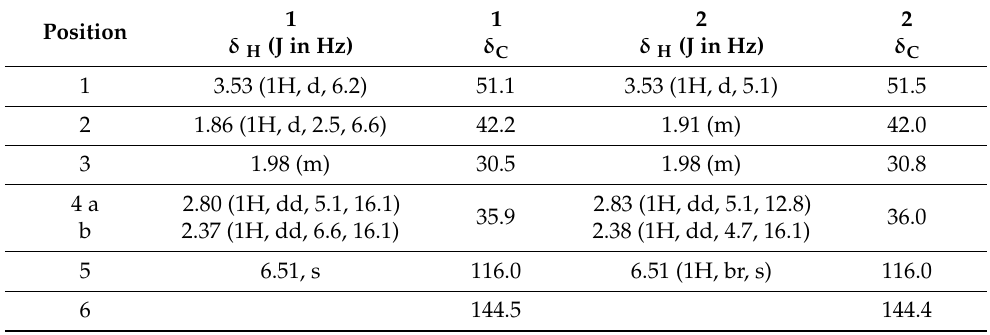
Table 4. Spectral data of 1 H-NMR (600 MHz) and 13 C-NMR (150 MHz) 3 (cid:48)